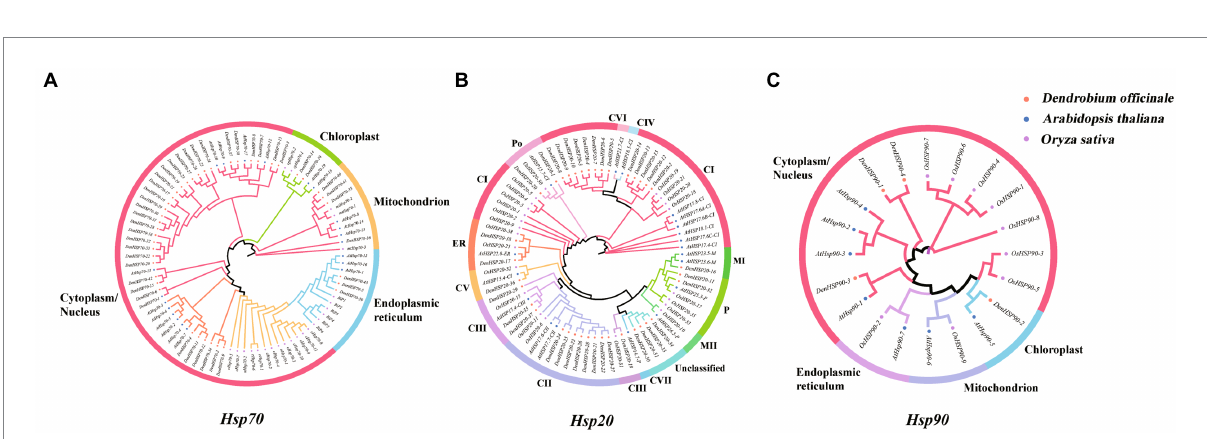
FIGURE 2 (A–C) represent the phylogenetic relationships of Hsp20 , Hsp70 and Hsp90 genes in D. officinale , A. thaliana and O. sativa , respectively. Three maximum likelihood phylogenetic trees were constructed by RAxML with 1000 bootstraps. Orange, green, purple colors represent Hsp20 , Hsp70 and Hsp90 protein sequences from D. officinale (Den), A. thaliana (At) and O. sativa (Os), respectively. Different subfamilies are shaded with different